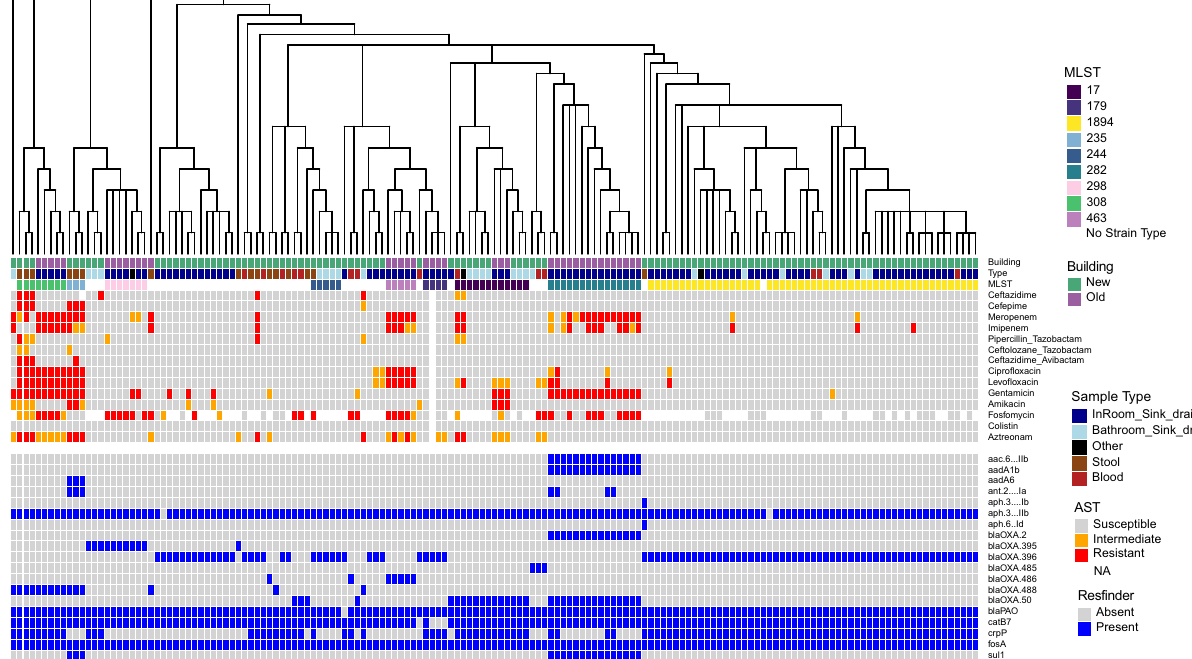
Fig. 5 Phenotypic and genotypic antibiotic resistance of collected P. aeruginosa isolates. Phylogenetic tree is from a core genome alignment. Phenotypic resistance determined by antibiotic susceptibility testing (AST). Genotypic resistance determined by Res fi nder 53